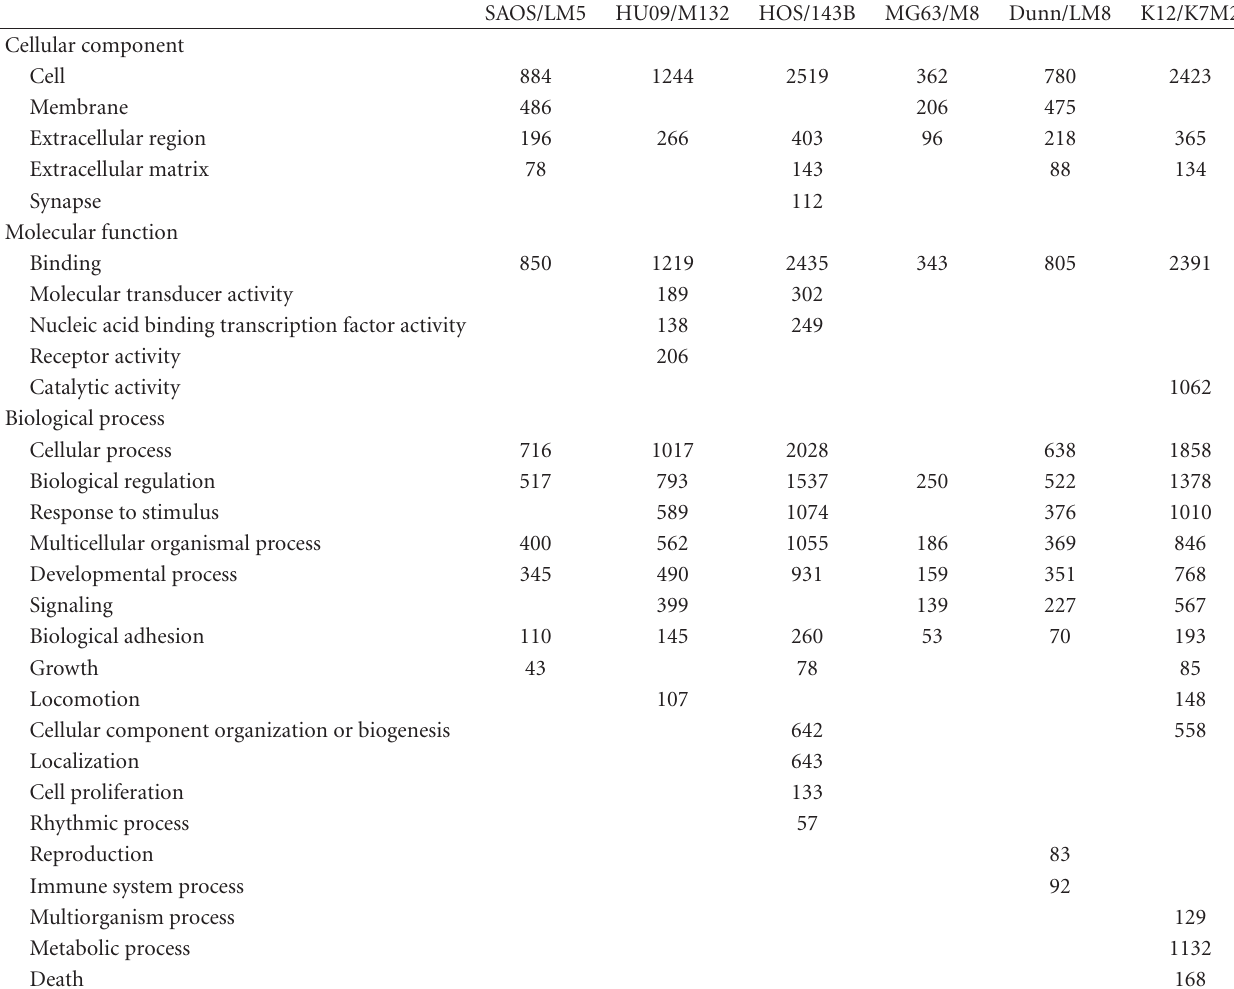
Table 2: Number of regulated ( > 2-fold; fdr < 0.01) probe sets enriched (fdr < 0.00001) in GO terms level 1.